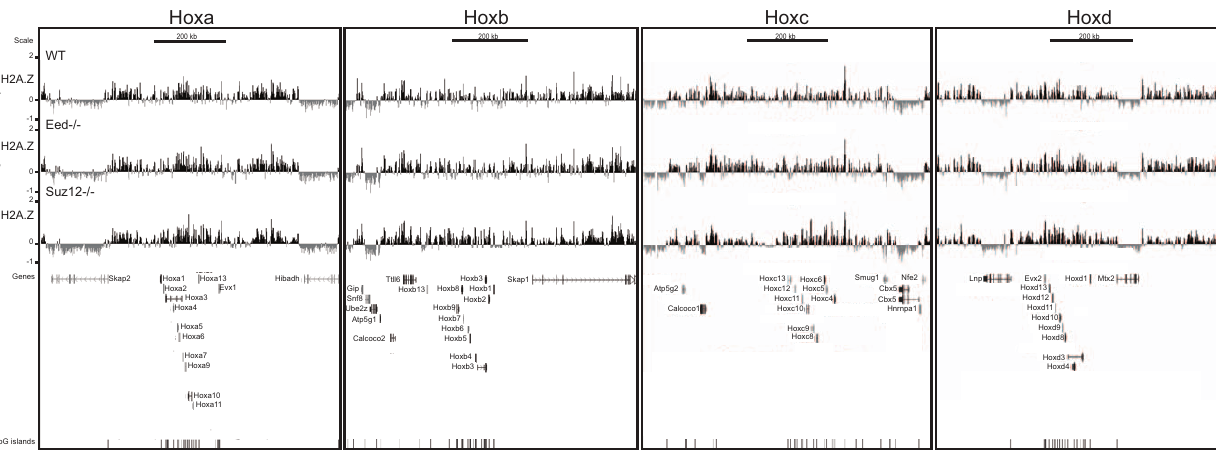
Figure 6 . H2A.Z occupancy is not affected at Hox loci in PRC2 mutant ESCs. Log2 of ChIP: input for: H2A.Z from WT ( + / + ) (top) and Eed 2 / 2 (mid) and Suz12 2 / 2 (bottom) ESCs using a custom tiling microarray. Data is shown for the four paralogous murine hox loci (Hoxa, Hoxb, Hoxc and Hoxd) and their flanking genomic regions. The data represent a mean of 2 biological replicates, (3 technical replicates). RefSeq gene annotations and CGIs are from the July 2007 (mm9) Build 37 assembly of the mouse genome (genome.ucsc.edu).